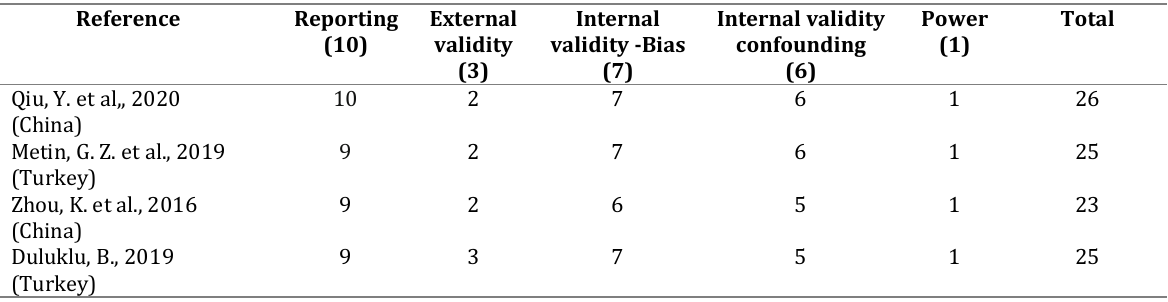
Table 3. Supportive therapy of each study